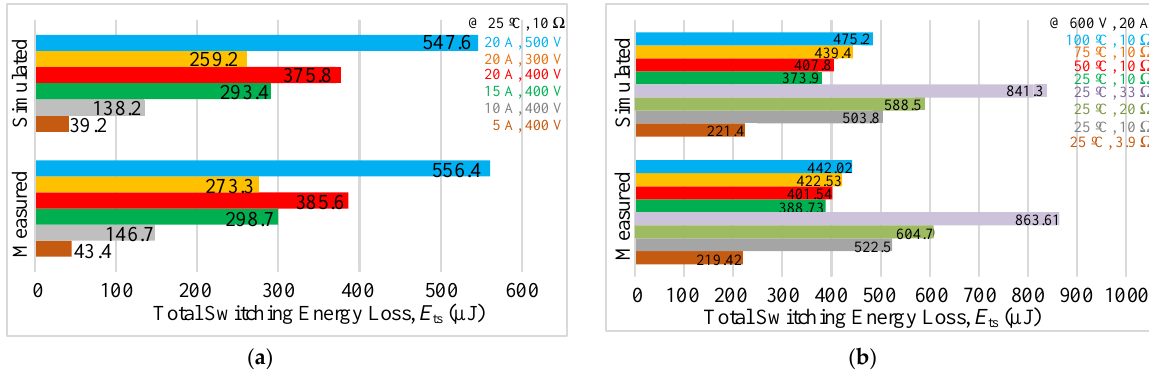
Figure 17. Power losses of Si MOSFET under various values of ( a ) voltage and current, ( b ) temperature.